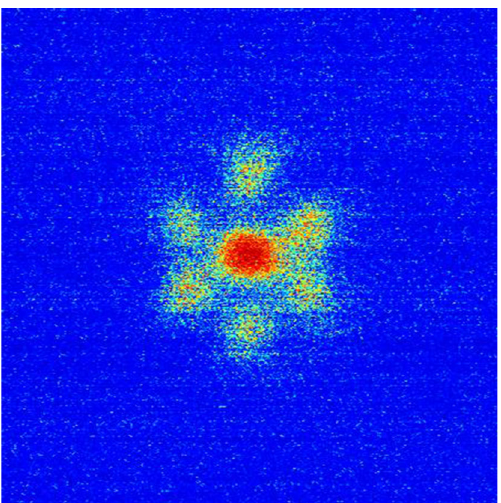
Fig. 3 FFDP of a 1 in. CCR, heated at 70 ◦ C, during a thermovacuum test. Blue corresponds to no energy, red to maximum energy, other colours to intermediate